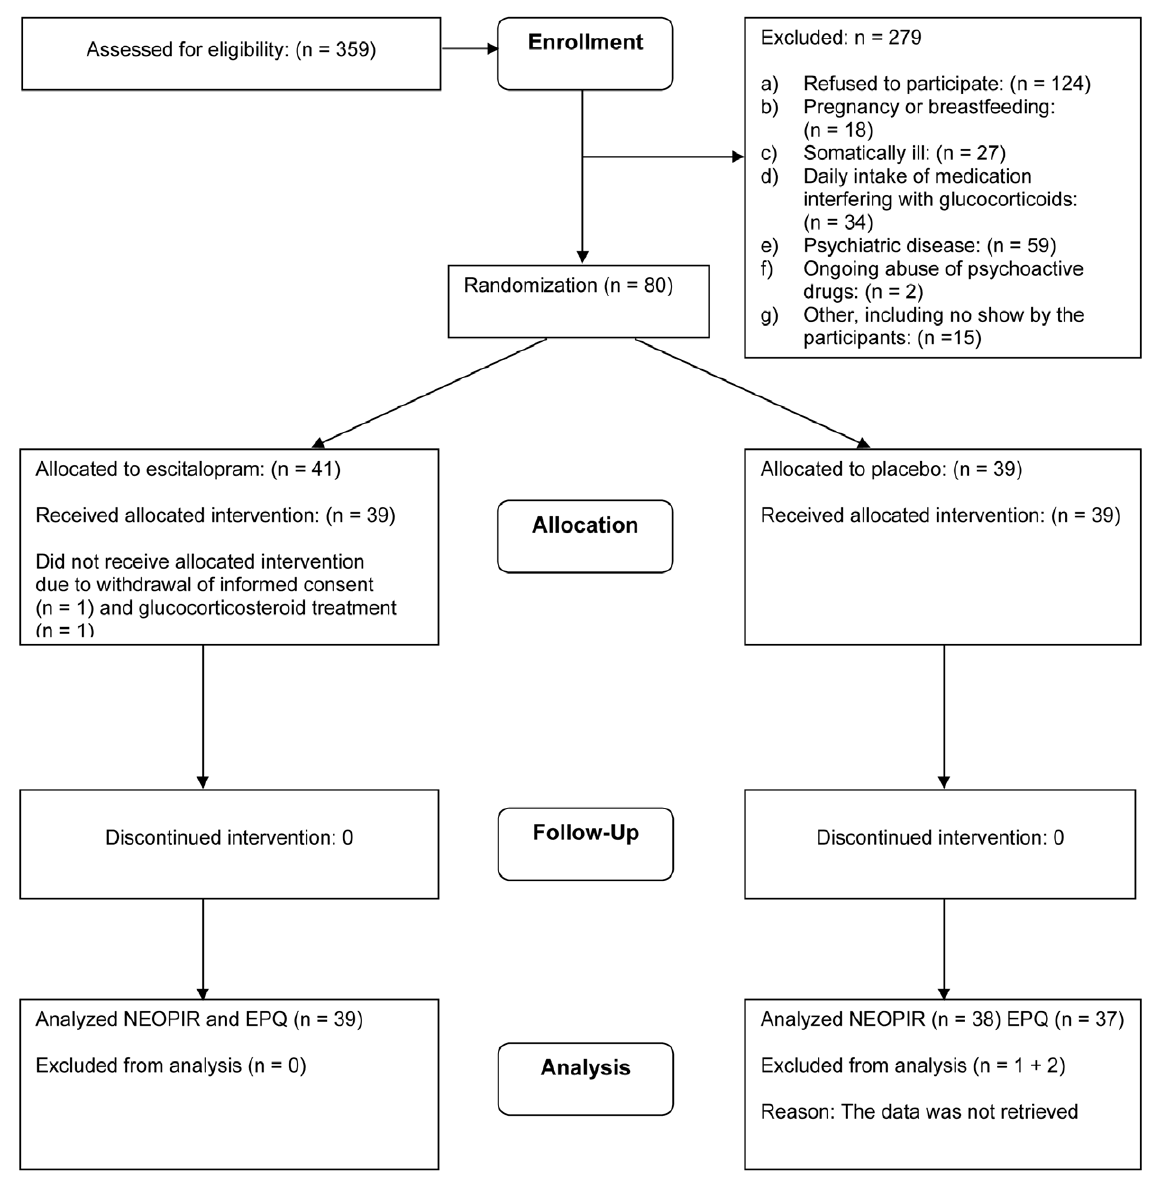
Figure 1. Flowchart consort for Agenda Trial Neuroticism.